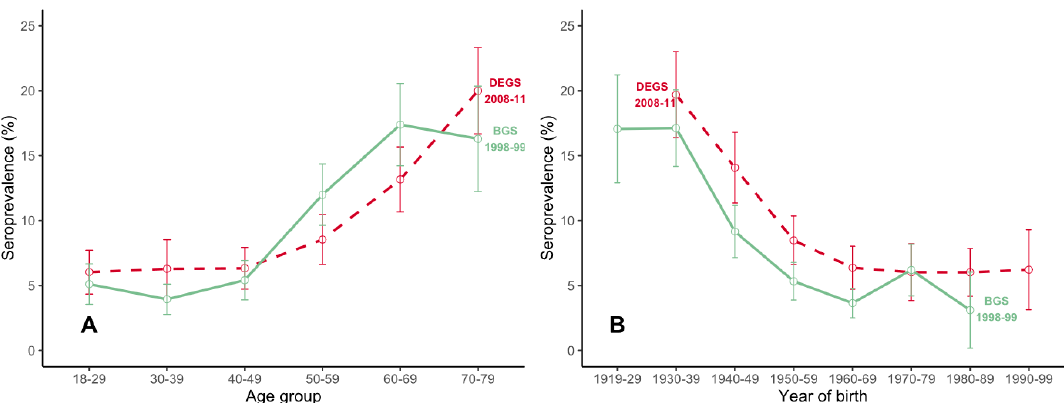
Figure 1. Weighted prevalence of burgdorferi antibodies by age group ( A ) and year of birth ( B